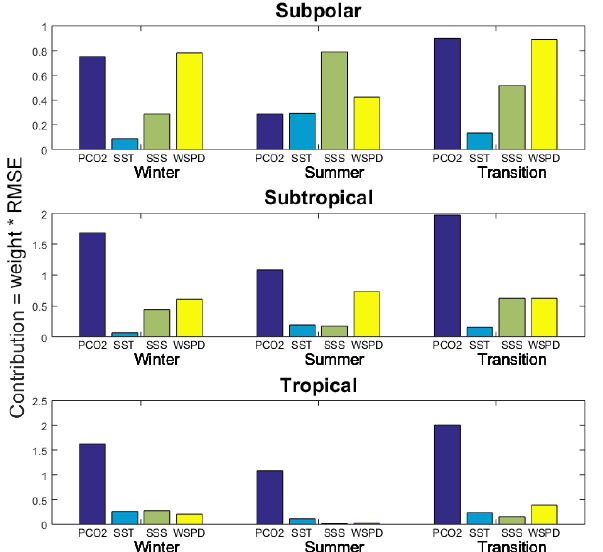
Figure 10. Contributions to the p CO 2sw bias in the model from SST, SSS, wind speed (WSPD) and nitrate (NIT) in the winter, summer, and transitional regimes. Contributions are computed as in Fig. 9 (see details in the text). The entire North Atlantic is dif- ferentiated into subpolar, subtropical, and tropical regions to better account for regional differences in the model biases and obtain a better linear fit for the computation of the weights in Eq.